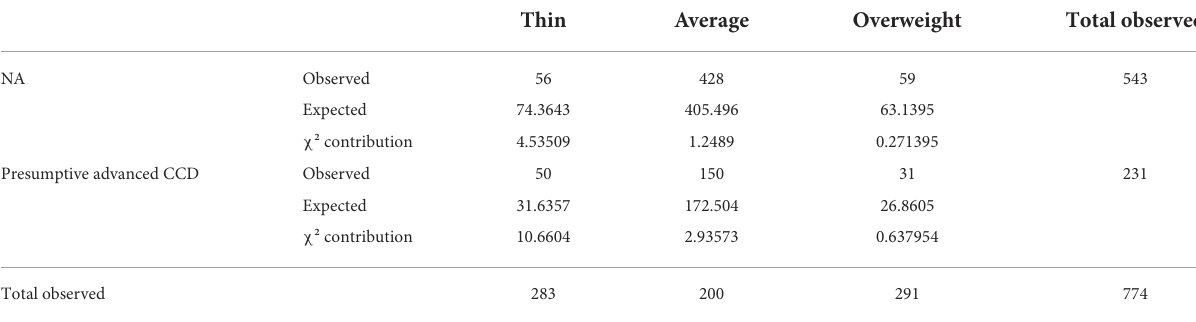
TABLE 5 Evaluation of the association of body condition score between NA and presumptive Advanced CCD groups using the chi-square test [degrees of freedom: 2; chi-square ( χ ² ): 20.2895; p -value: 0.00003928].